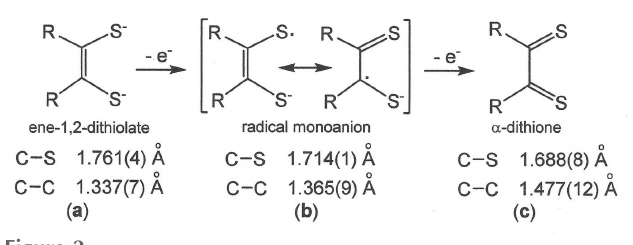
Figure 2 Redox levels of the dithiolene ligand with typical intraligand bond lengths.